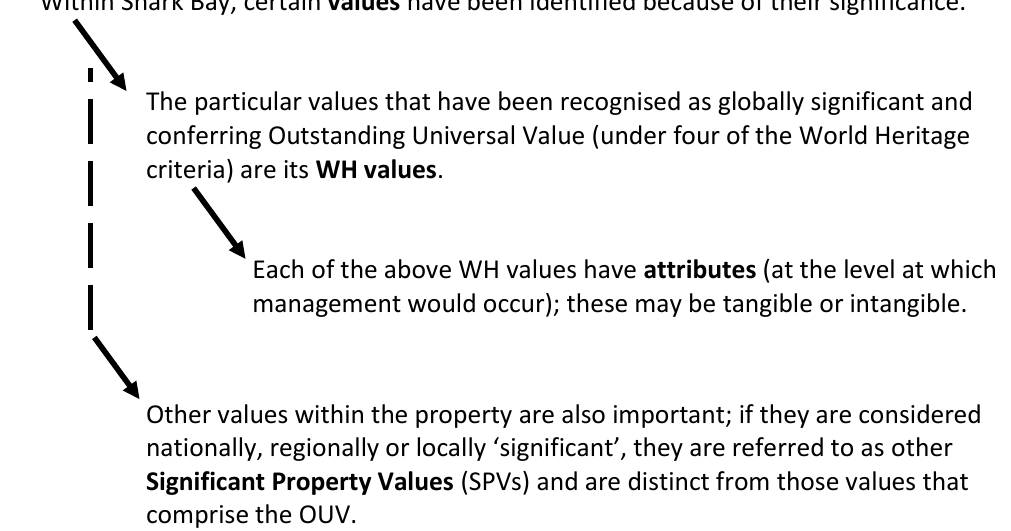
Figure 2.2 Hierarchy of World Heritage terminology as used in this CVI assessment report for Shark Bay, Western Australia.